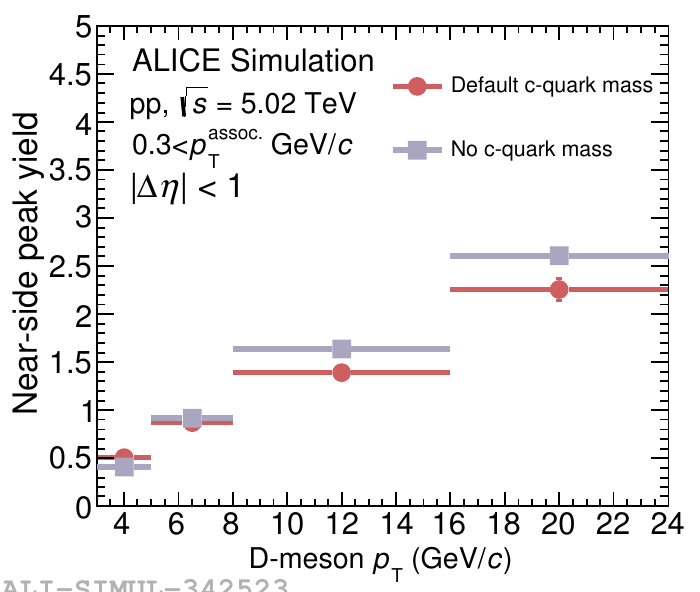
√ s = 5.02 TeV, as a